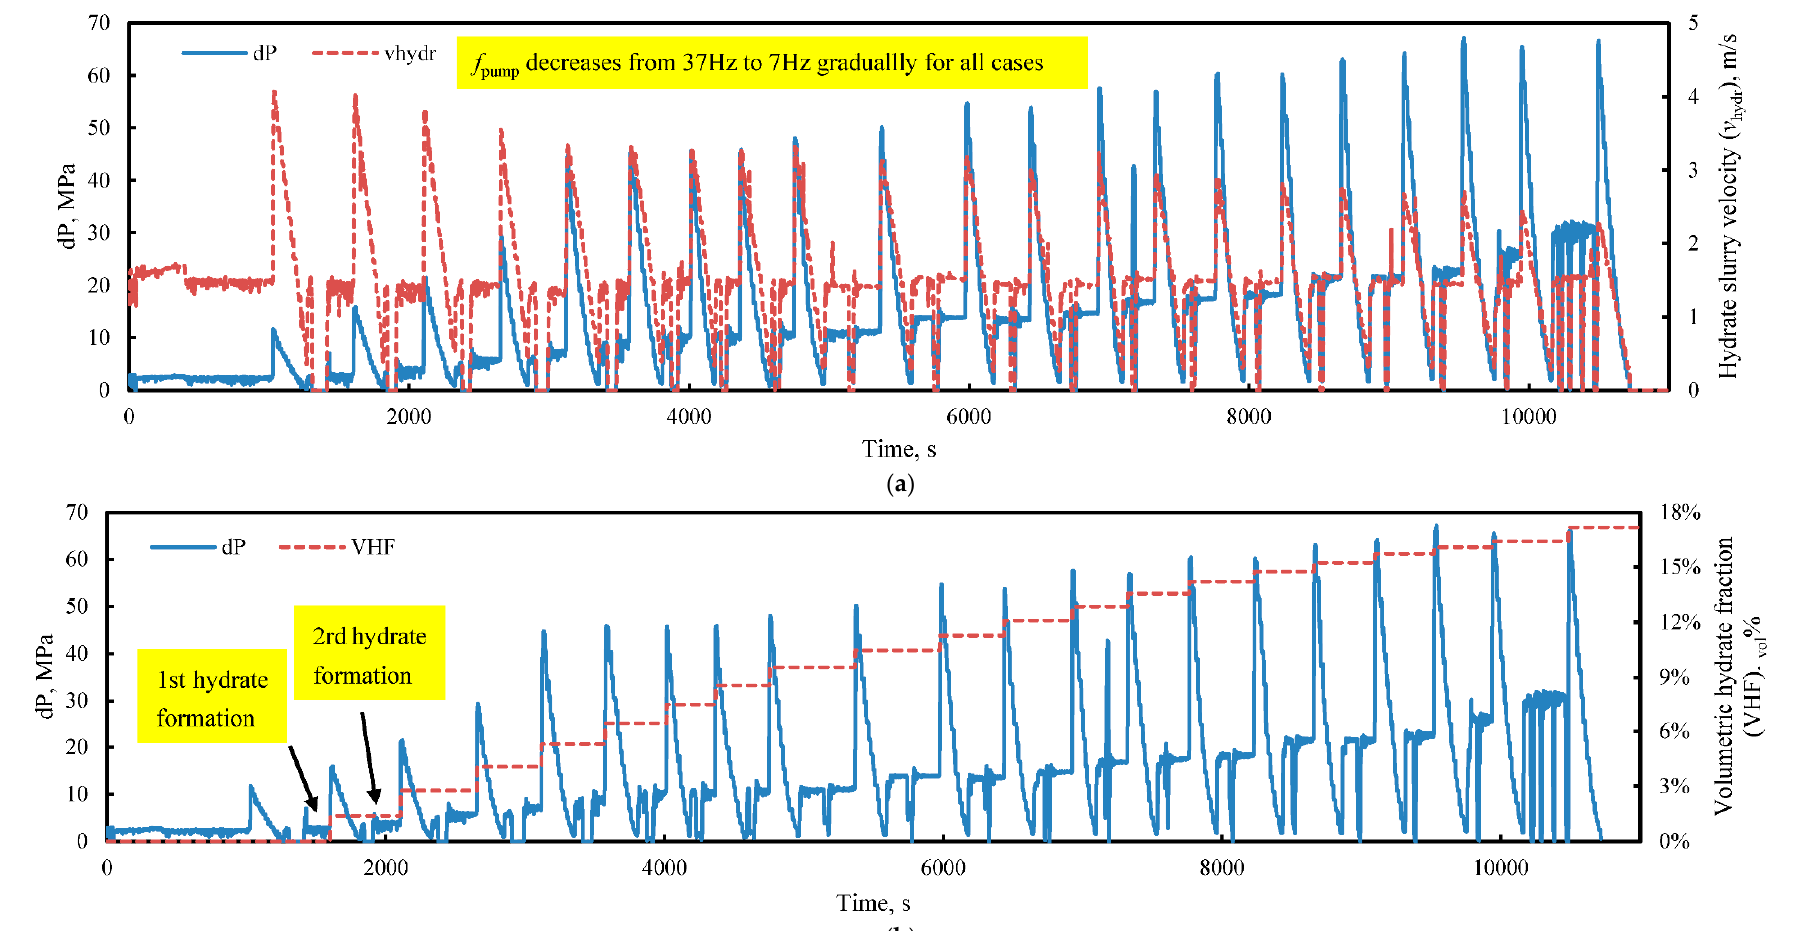
Figure 2. Variations of key flow parameters in the experiment. ( a ) Variations of pressure drop and hydrate slurry velocity in the experiment. ( b ) Variations of pressure drop and volumetric hydrate fraction in the experiment.